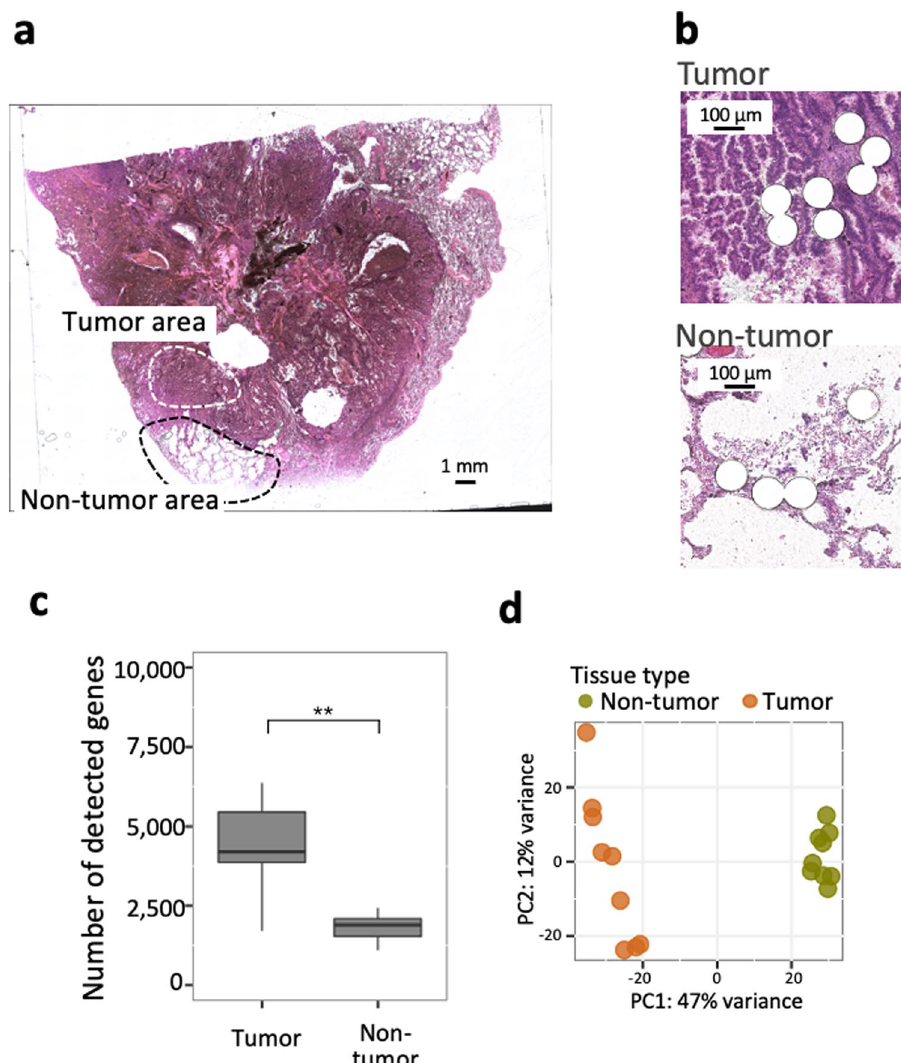
(thickness: 10 μm) were obtained from a surgical resected sample that had been archived at room temperature for 6 years. After deparaffinization and HE staining, PuTi-spots were punched and collected under microscopic observation. ( b ) Image after PuTi-spot collection. Each white circle (diameter: 100 μm) corresponds to the location at which the PuTi-spot was punched out. ( c ) Comparison of the detected gene numbers. The quantity of total RNA samples was assessed, which was equivalent to the number of genes detected in the micro-region samples. The number of genes detected from the micro-regions roughly corresponded to 500–5000 pg of total RNA. Statistical analysis based on Welch’s t -test. The p values were calculated and visualized using the ggplot2 40 (version 3.3.0) and ggpubr 39 (version 0.4.0) packages in R. ** P value < 0.01. ( d ) PCA of gene expression data. PCA was performed using gene expression data from tumor or non-tumor-derived PuTi-spots (N = 10, respectively). Two different clusters were identified, and the distribution of the plots showed different trends between the groups. The amount of variance in percentages accounted for by each principal component is shown on each axis. RNA-seq RNA-sequencing, PuTi-spot micro-punched tissue spot, HE hematoxylin–eosin, PCA principal component